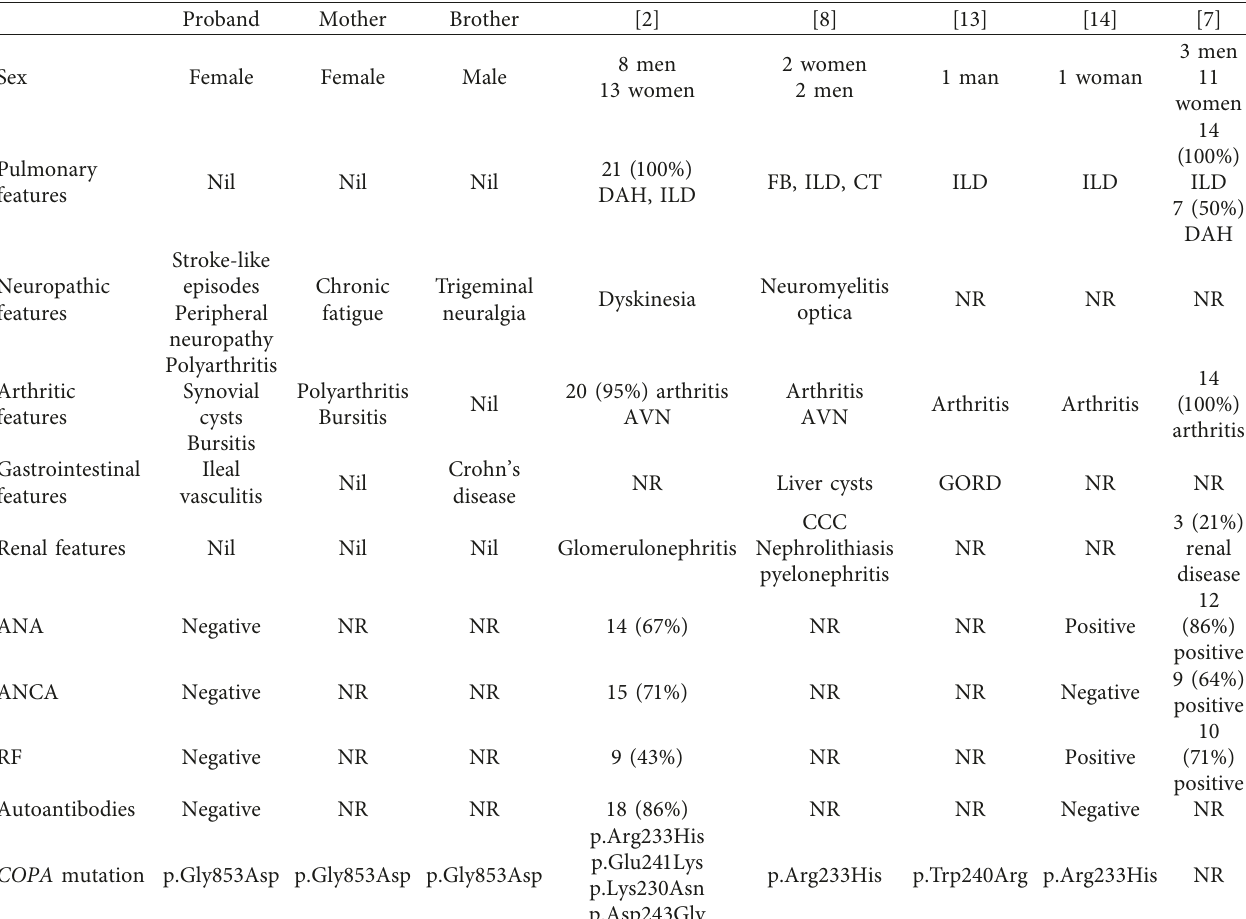
Table 1: Clinical and molecular presentations of COPA